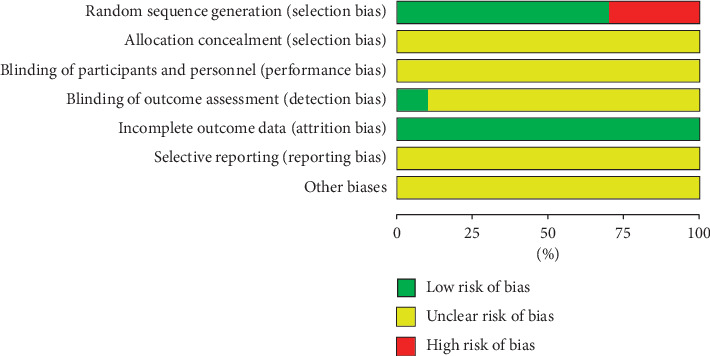
Risk of bias graph.